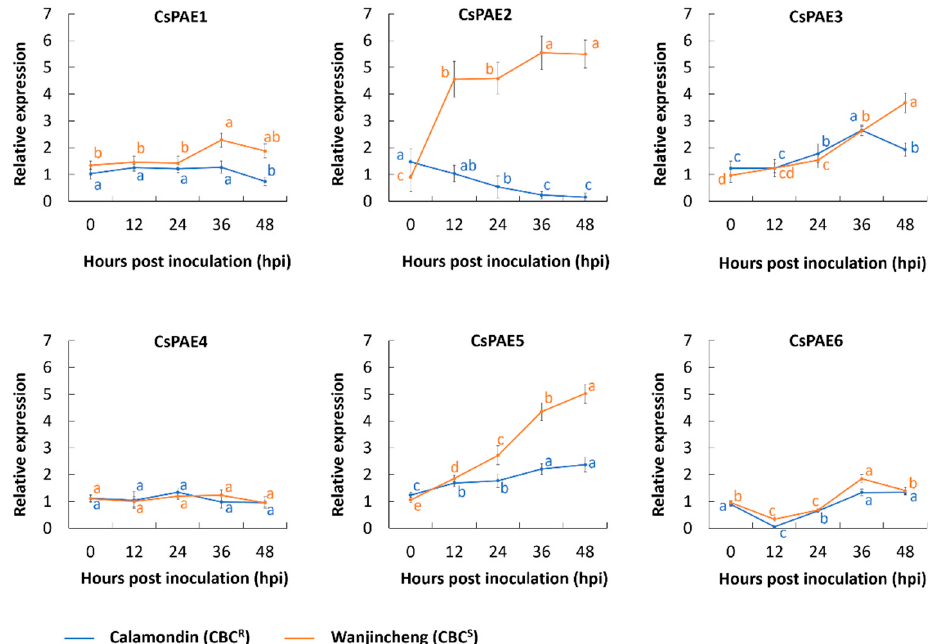
Figure 4. CsPAE expression profiles under the infection of Xcc . Wanjincheng (orange) and Calamondin (blue) were infected with Xcc for 0, 12, 24, 36, and 48 h, after which CsPAE expression was assessed via qRT-PCR, with CsActin being used for the normalization. Uninfected control samples were inoculated using LB medium. Data are means ± SEs. Duncan’s multiple range test was used to compare the data ( p = 0.05), with three biological replicates per sample. The significance of the di ff erence was marked by lowercase letters (a–e).